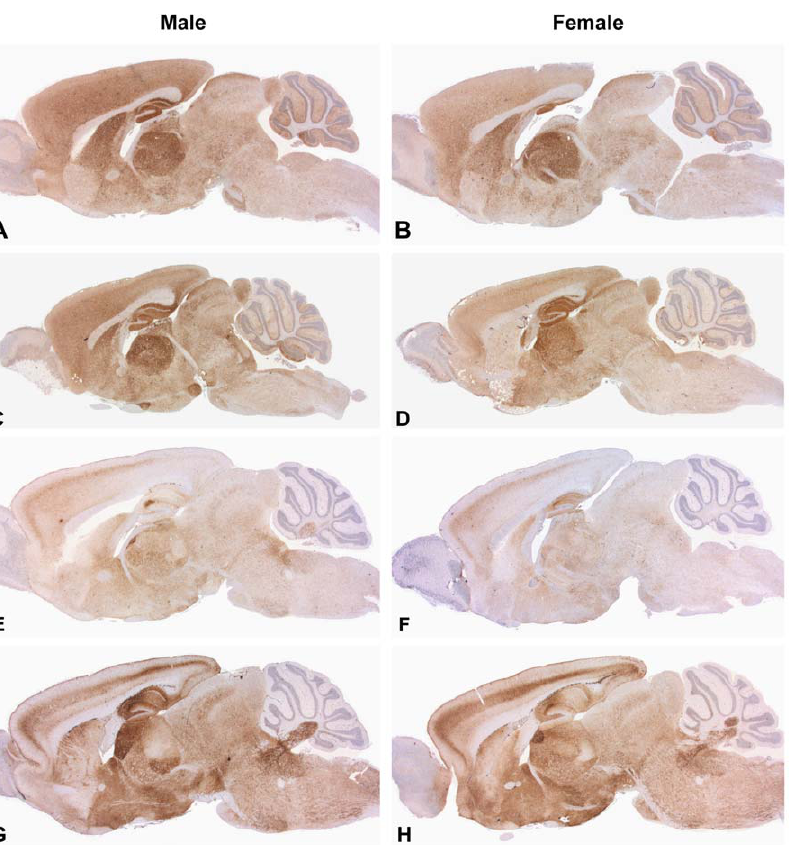
Figure 4. PrP Sc distribution in the brains of C57BL/6 and FVB/N mice. Comparison of prion protein staining between male (A, C, E, G) and female (B, D, F, H) mice inoculated with ME7 prions (A–D) and MRC2 prions (E–H). A, B and E, F represent C57BL/6 mice and C, D and G, H represent FVB/N mice. Overall, the pattern of PrP Sc distribution shows no difference between male and females and is characteristic of the prion strain used. Scale bar corresponds to 2.5 mm for all panels except for C and D where it corresponds to 3 mm.